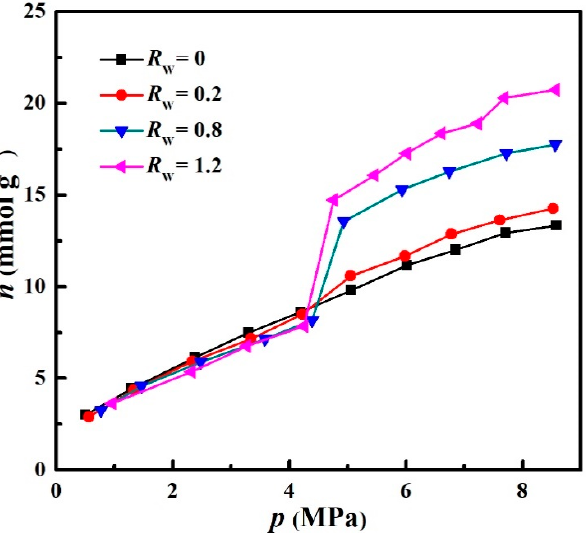
Figure 5. Methane adsorption isotherms of hollow ZIF ‐ 8 nanoparticles with different amounts of pre ‐ adsorbed water at 275 K.